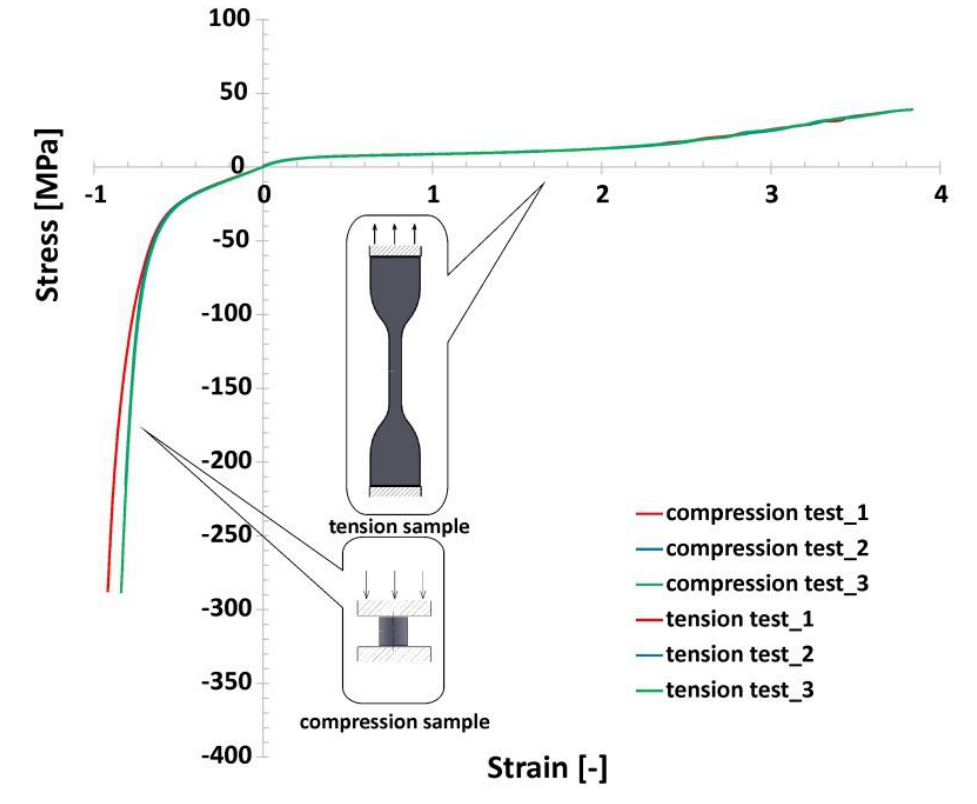
Figure 12. The uniaxial compression and tensile tests of the 3D printed TPU material under normal temperature conditions.